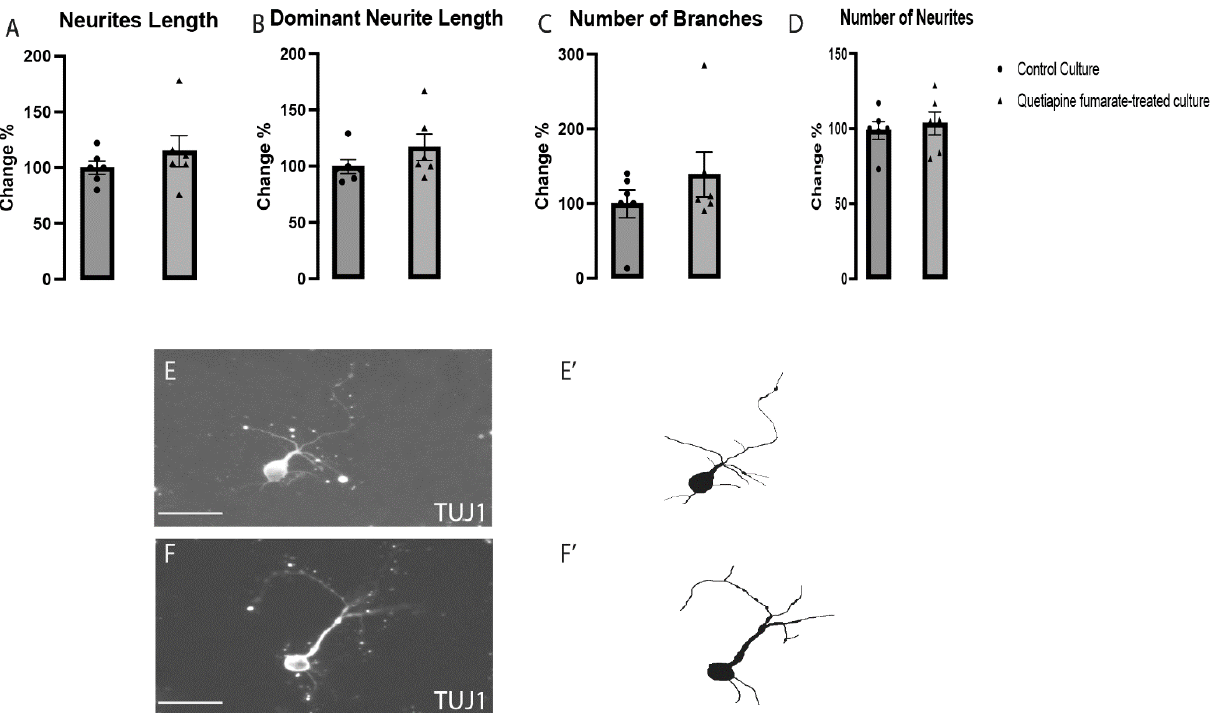
Figure 3. QEPF exposure did not affect the morphology of non-dopaminergic VM neurons ( A – D ). Representative images and illustrations for non-dopaminergic VM neurons immunolabeled with TUJ1 in both groups: control ( E , E’ ) and QEPF-treated ( F , F’ ) show no significant differences between groups. Data expressed as mean ± SEM, n = 3 technical replicates, 6 biological replicates.